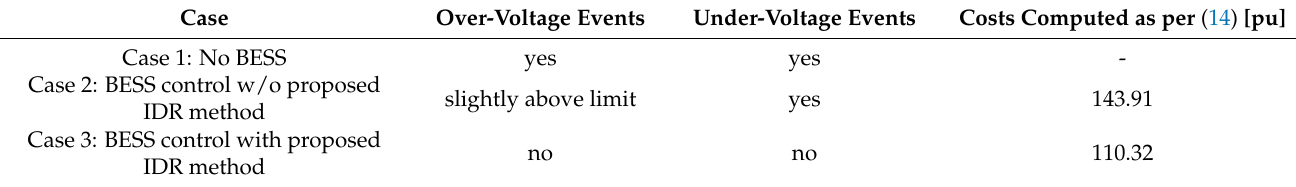
Figure 7. Plot of case 3: ( a ) setpoints of BESS, ( b ) SOC of BESS, and ( c ) node voltages at end of the feeder. Table 1. Summary of the Simulation